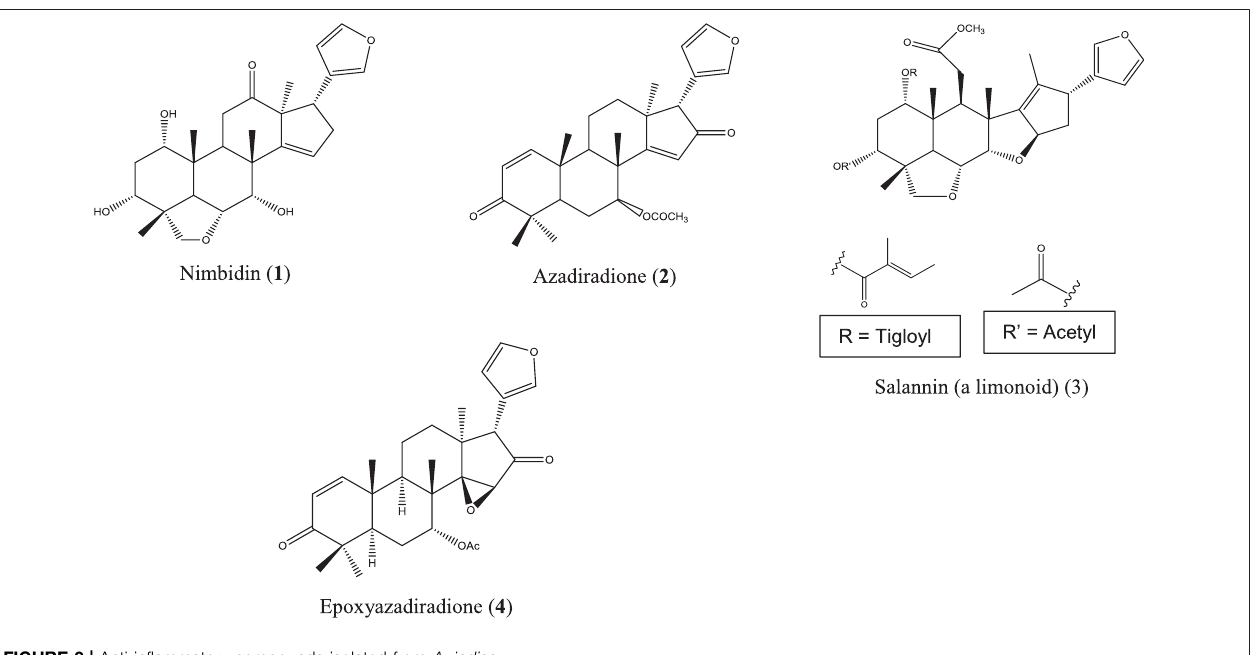
FIGURE 3 | Anti-in fl ammatory compounds isolated from A. indica